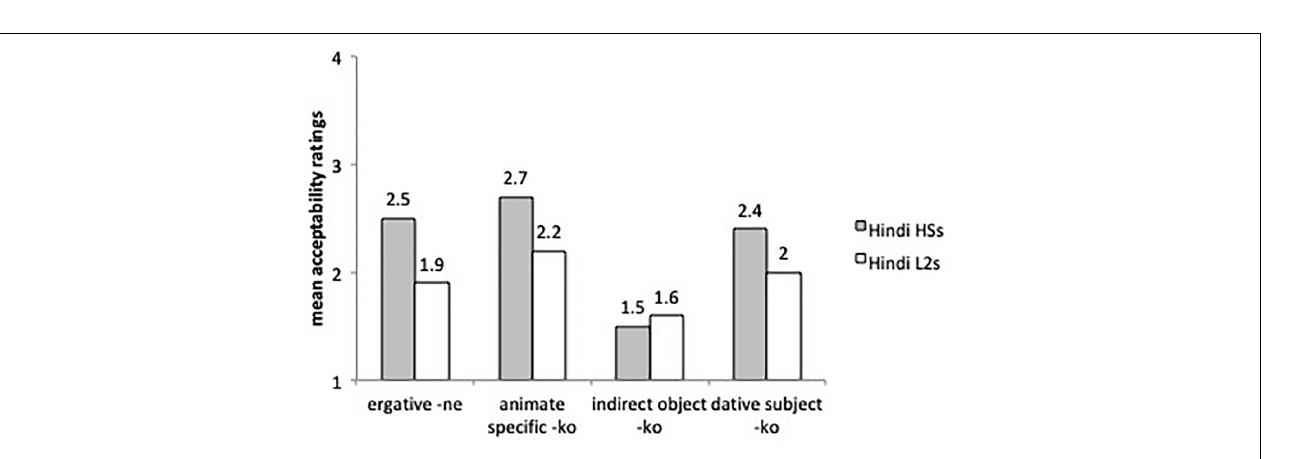
FIGURE 7 | Mean acceptability ratings on ungrammatical sentences with omission of obligatory case